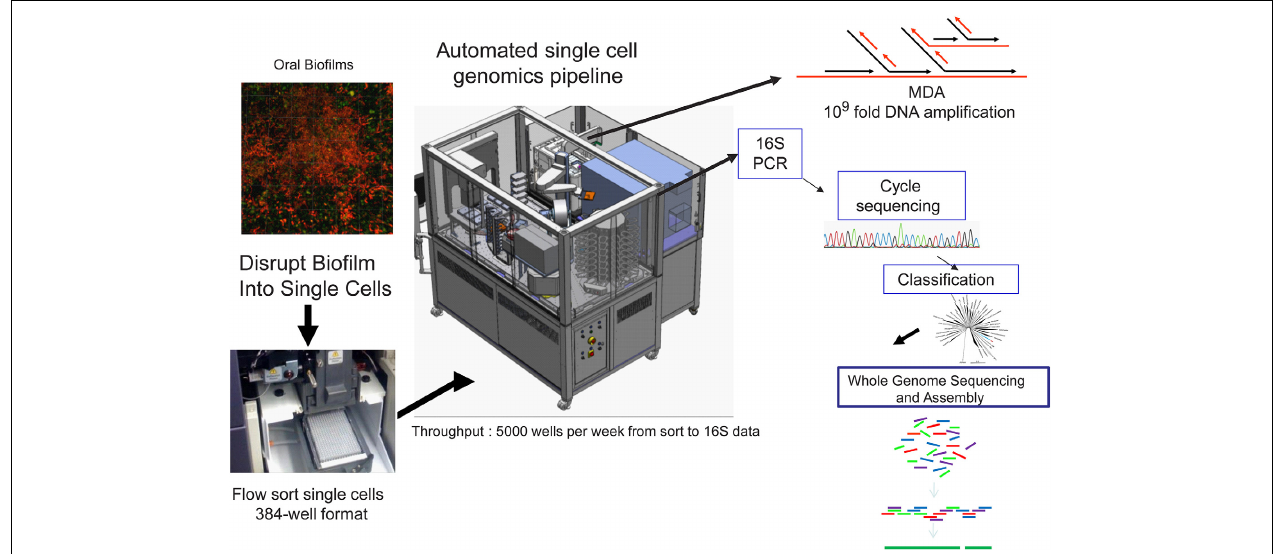
FIGURE 3 | Workflow of the high-throughput Single Cell Genomics Platform at the J. Craig Venter Institute. Custom integrated Agilent Technologies BioCel 1200 liquid handling automated platform for high throughput single cell genomics. The BioCel platform allows processing of more than 5000 single cells per week through a multi-stage protocol